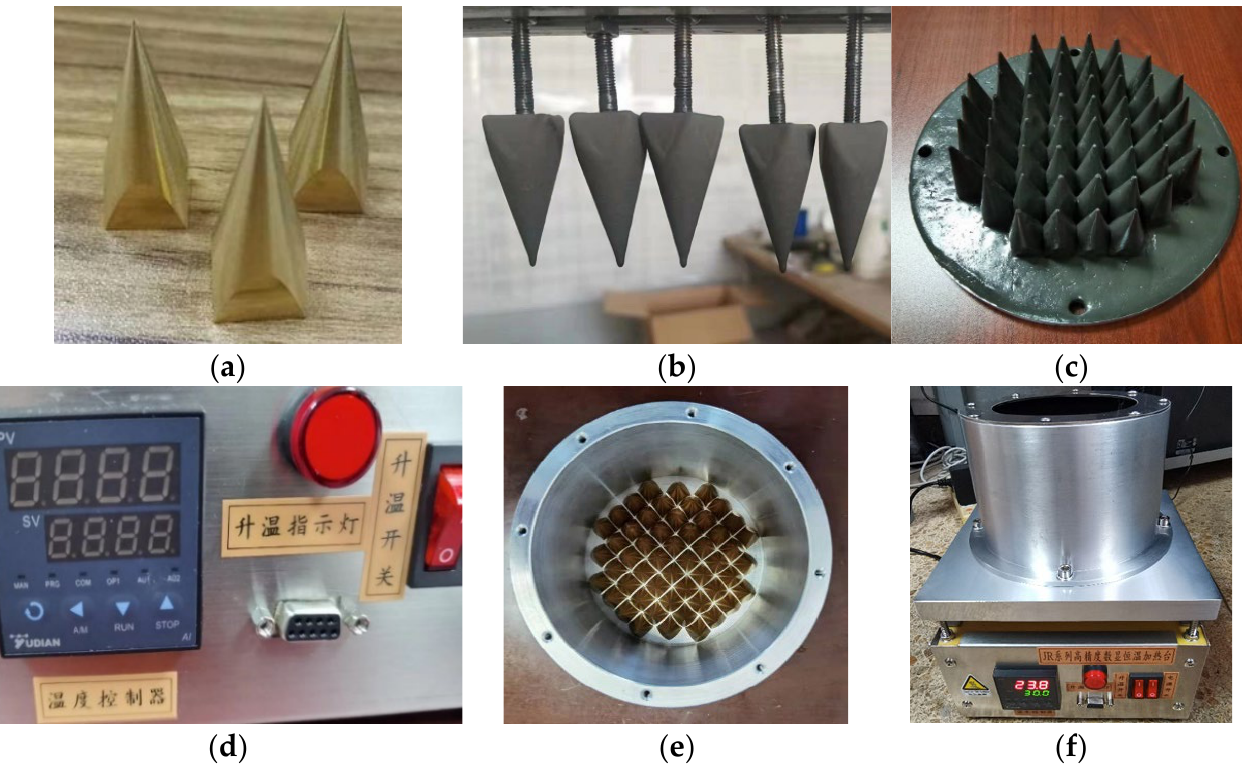
Figure 15. The figures for the blackbody calibration target. ( a ) Metal cone; ( b ) Coated cone; ( c ) Coated cone array; ( d ) Temperature controller; ( e ) The cavity of the calibration target; ( f ) Complete blackbody calibration target.